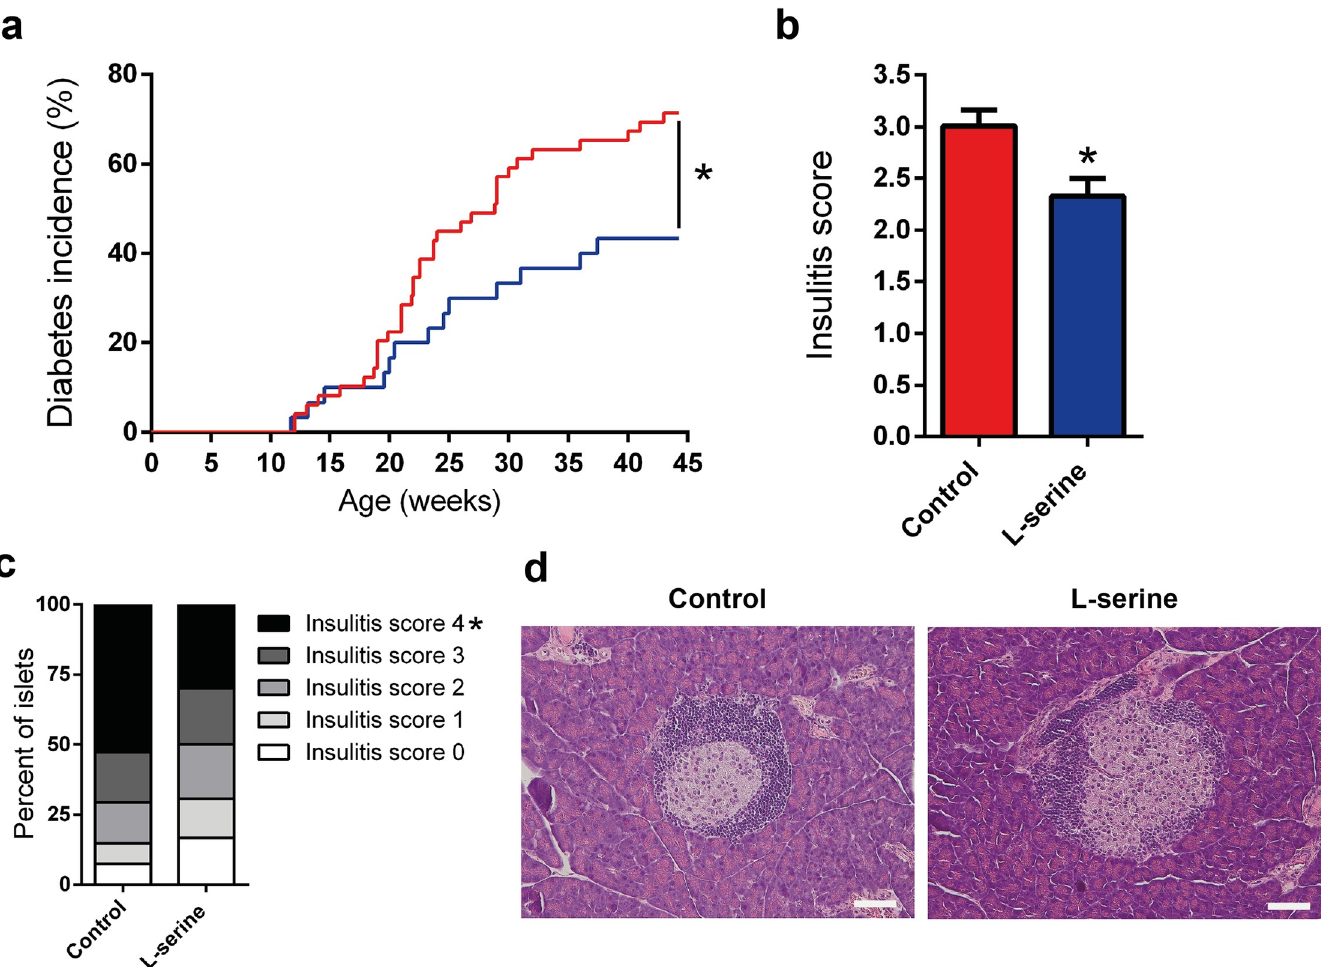
Fig 1. L-serine reduces autoimmune diabetes incidence and insulitis score in NOD mice. (a) Kaplan-Meier survival curves showing diabetes incidence up to 45 weeks of age. Blood glucose was measured once a week and diabetes diagnosis were based on two blood glucose measurements with an interval of two days (cid:21) 12mM, control (n = 49) and L-serine (n = 30), p = 0.02. (b) Insulitis score in 13-weeks-old NOD mice, 30 islets were scored per mouse. n = 5. Shown is mean ± SEM. p = 0.02. (c) Percentage distribution of insulitis levels: 0 (white), 1 (light grey), 2 (grey), 3 (dark grey), and 4 (black). p = 0.03, for insulitis level 4. (d) Representative images of insulitis level in control and L-serine mice. Scale bar, 50 μ m. Control is shown in red and L-serine in blue. Statistical tests: Mantel-Cox log-rank test (a) and unpaired two-tailed Student’s t -test (b, c). (cid:3) p < 0.05.